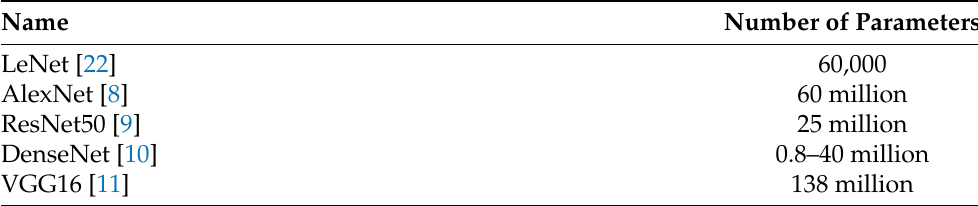
Table 1. Summary of some well-known CNNs and their number of